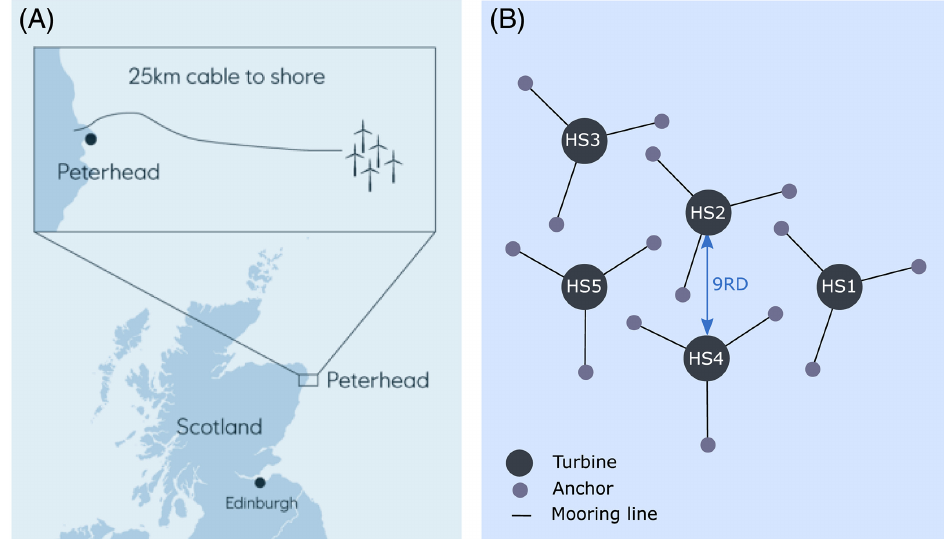
Figure 12. ( A ) The Hywind Scotland wind park is located 25 km east of Peterhead in Scotland. ( B ) Layout of the wind park consisting of five turbines labeled HS1 to HS5. A blue arrow marks the distance of 9 rotor diameters (RDs) between the turbines